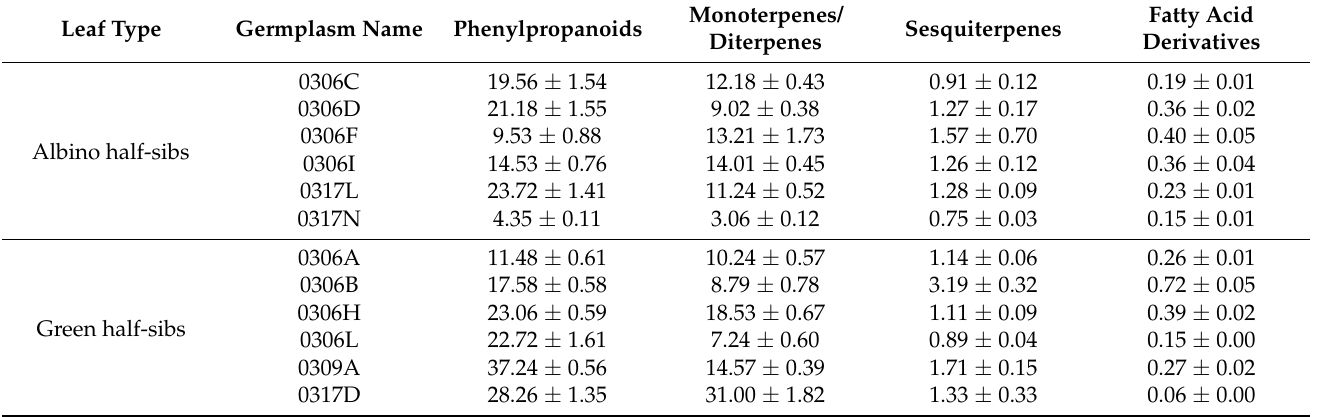
Table 1. The fresh tea leaf volatile contents from the albino half-sibs and the green half-sibs of Camellia sinensis cv Baijiguan ( µ g. g − 1 fresh